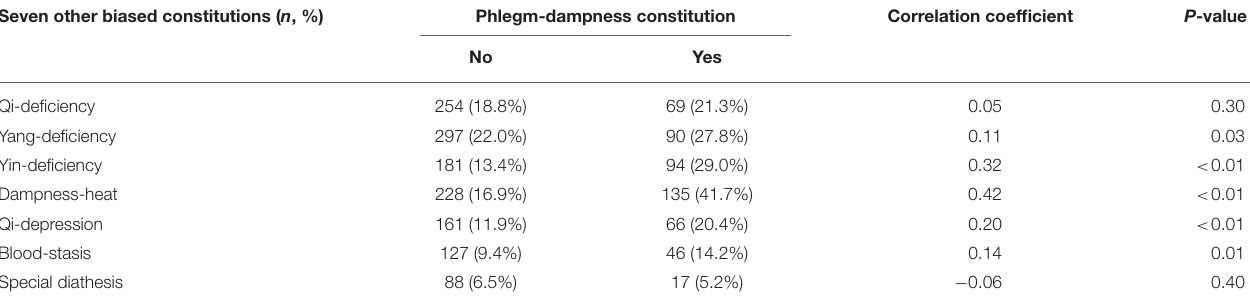
TABLE 2 | Association between the phlegm-dampness constitution and seven other biased constitutions in 1,677 participants. Seven other biased constitutions ( n , %) Phlegm-dampness constitution Correlation coefficient P